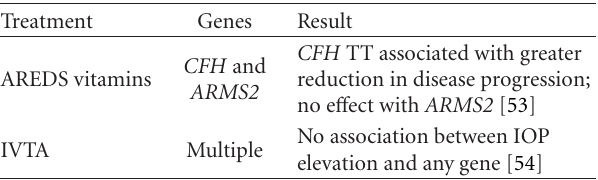
Table 1: Pharmacogenetics of AREDS vitamins and intravitreal triamcinolone